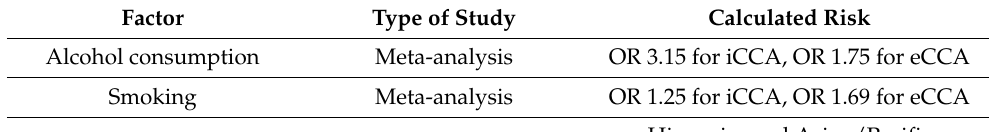
Table 1. Cont. Factor Type of Study Calculated Risk Alcohol consumption Meta-analysis OR 3.15 for iCCA, OR 1.75 for eCCA Smoking Meta-analysis OR 1.25 for iCCA, OR 1.69 for eCCA Hispanics and Asian/Pacific Islanders are more likely to have CCA Races Population-based study compared with Caucasians, and African American race is inversely associated with CCA Case-control study OR 4.8 for iCCA, OR 2.1 for eCCA Asbestos Case-control